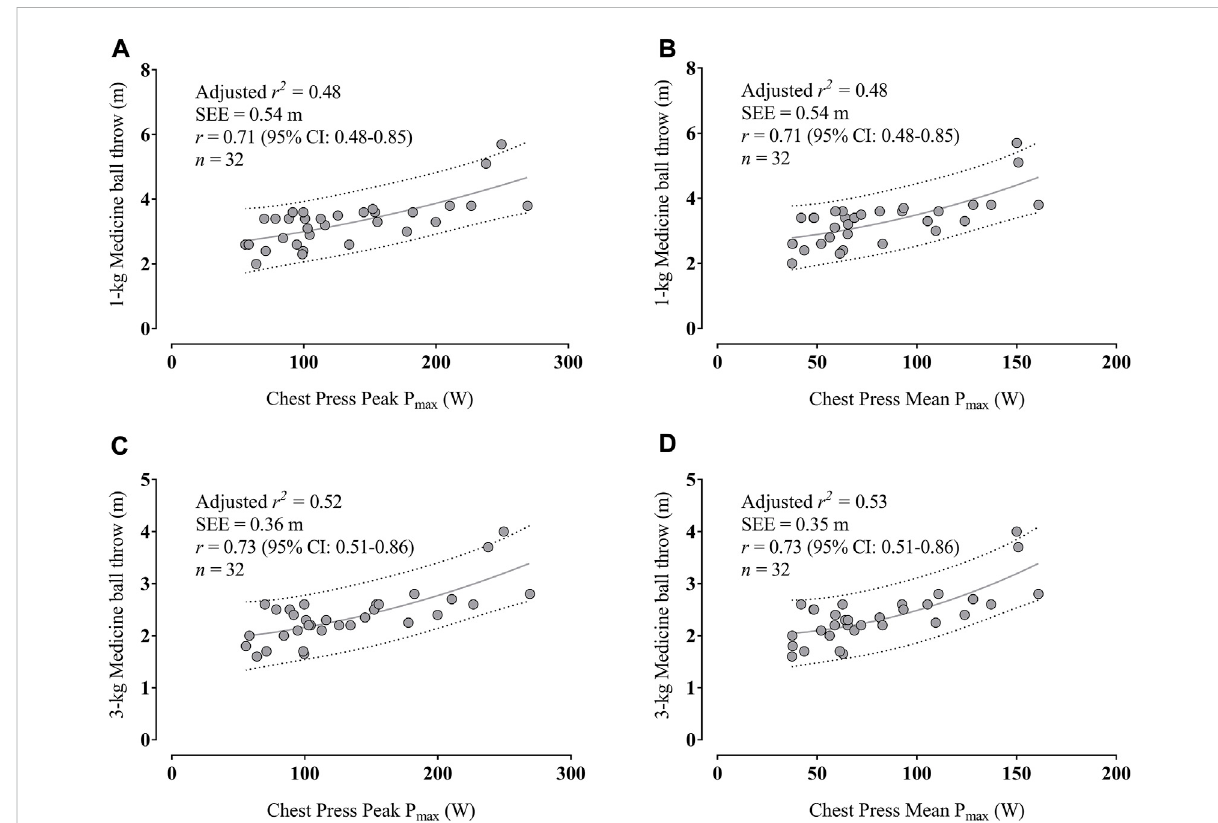
FIGURE 4 Associations between maximal peak power (A) and mean power output (B) in the chest press with 1-kg medicine ball throw and between peak power (C) and mean power output (D) with 3-kg medicine ball throw; Dotted lines indicate the prediction intervals. Abbreviation: CI, con fi dence interval; P max , maximal power output; SEE, standard error of the